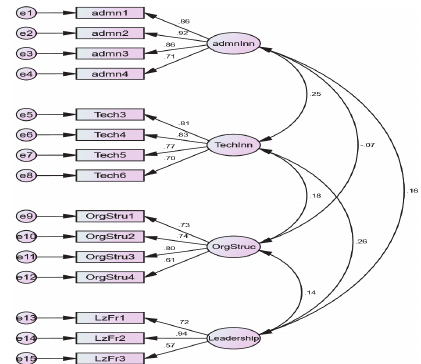
Fig. 1. Measurement model of the studied